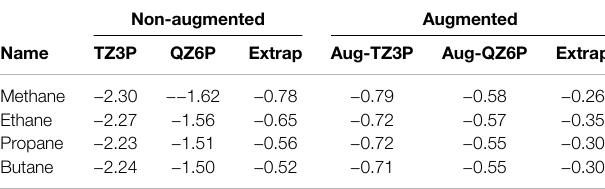
TABLE 1 | Comparison of electron af fi nities for linear alkanes from Methane to Butane using augmented, and non-augmented basis sets. Non-augmented